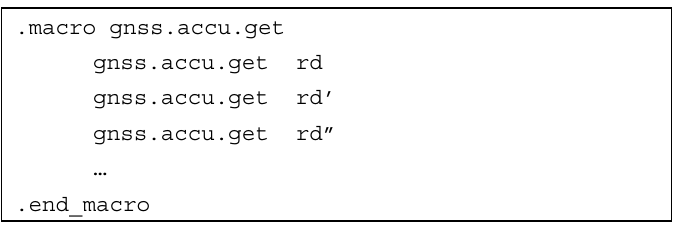
Figure 8. Accumulator data readout macro-instruction.